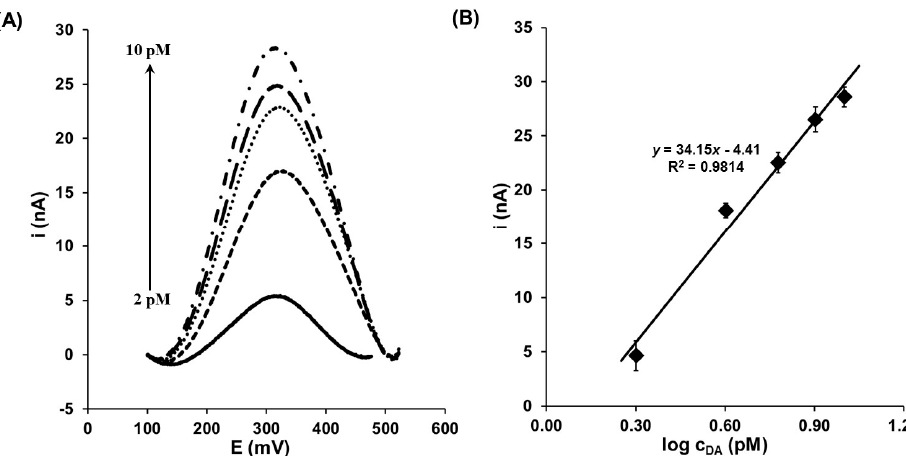
Figure 7. ( A ) Representative OSWVs recorded with gold electrode modified with HSCX—COOH/MET in the presence of DA at the concentration range from 2 to 10 pM; ( B ) The intensity of redox DA current vs. the logarithm from the concentration of DA measured with electrodes modified with HSCX—COOH/MET ( n = 5, 0.7 < SD < 1.4). Measuring conditions: 0.2 M McIlvain buffer pH 2.0 with 1 nM NEP, 1 nM EP, 0.1 mM AA and 0.1 mM UA. The OSWV was performed with step potential 0.5 mV, square-wave frequency 10 Hz, and square-wave amplitude 25 mV.